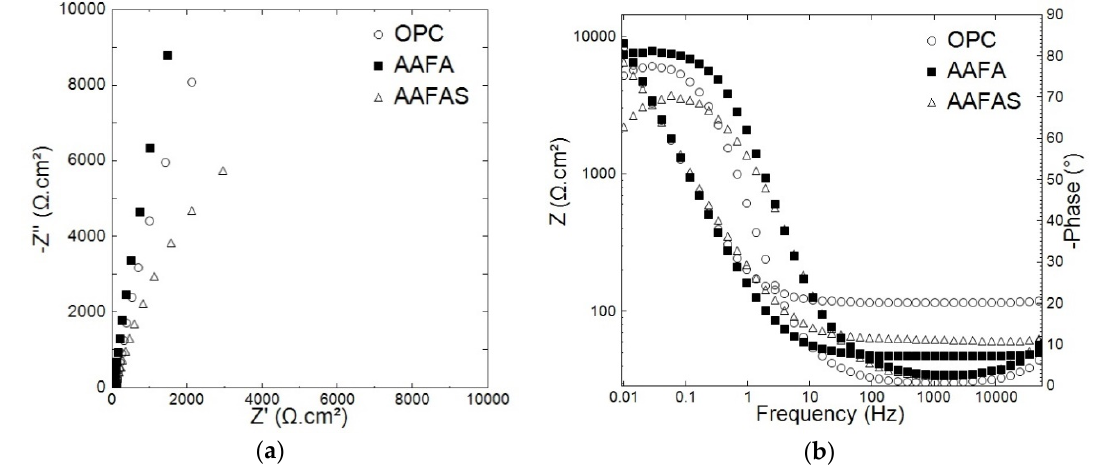
Figure 7. Nyquist ( a ) and Bode ( b ) diagrams of carbon steel embedded in OPC, AAFA, and AAFAS mortars cured for 35 days and before carbonation/leaching.